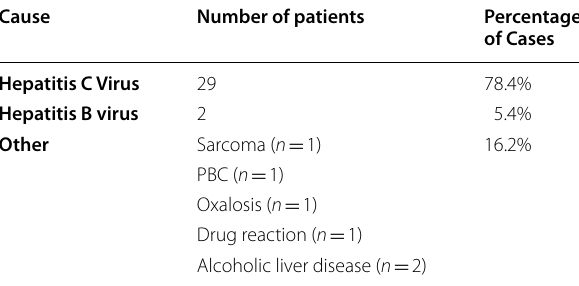
Table 3 Maintenance Immunosuppression Therapy in de